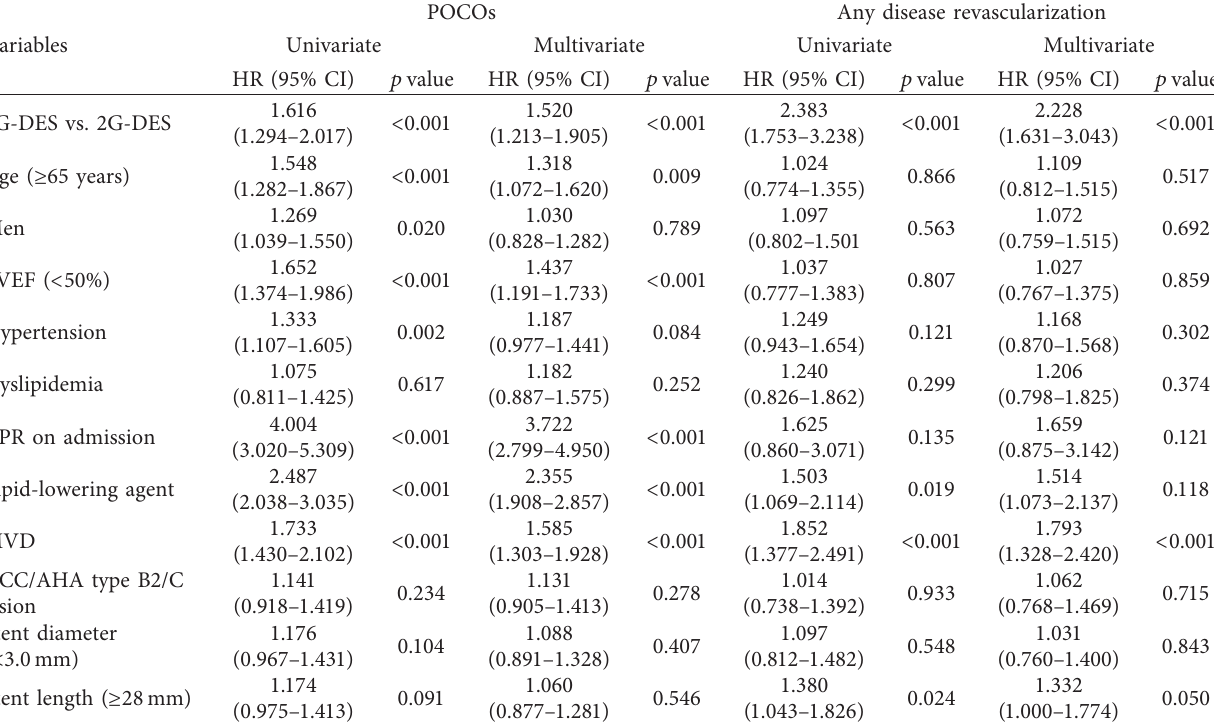
Table 3: Independent predictors for POCOs and any disease revascularization at 2 years in all